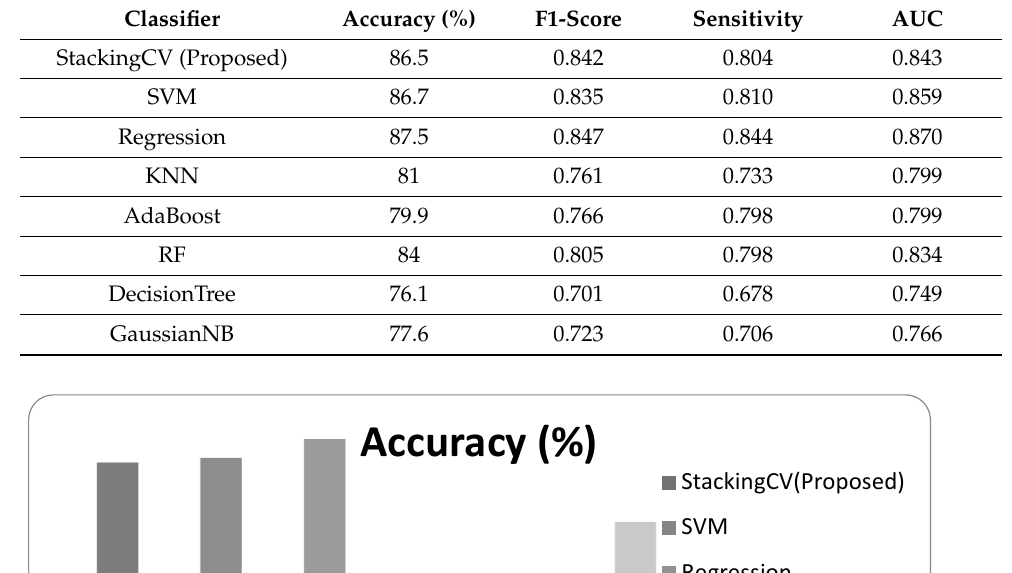
Table 4. Performance evaluation of the system for VGG16 feature extraction.